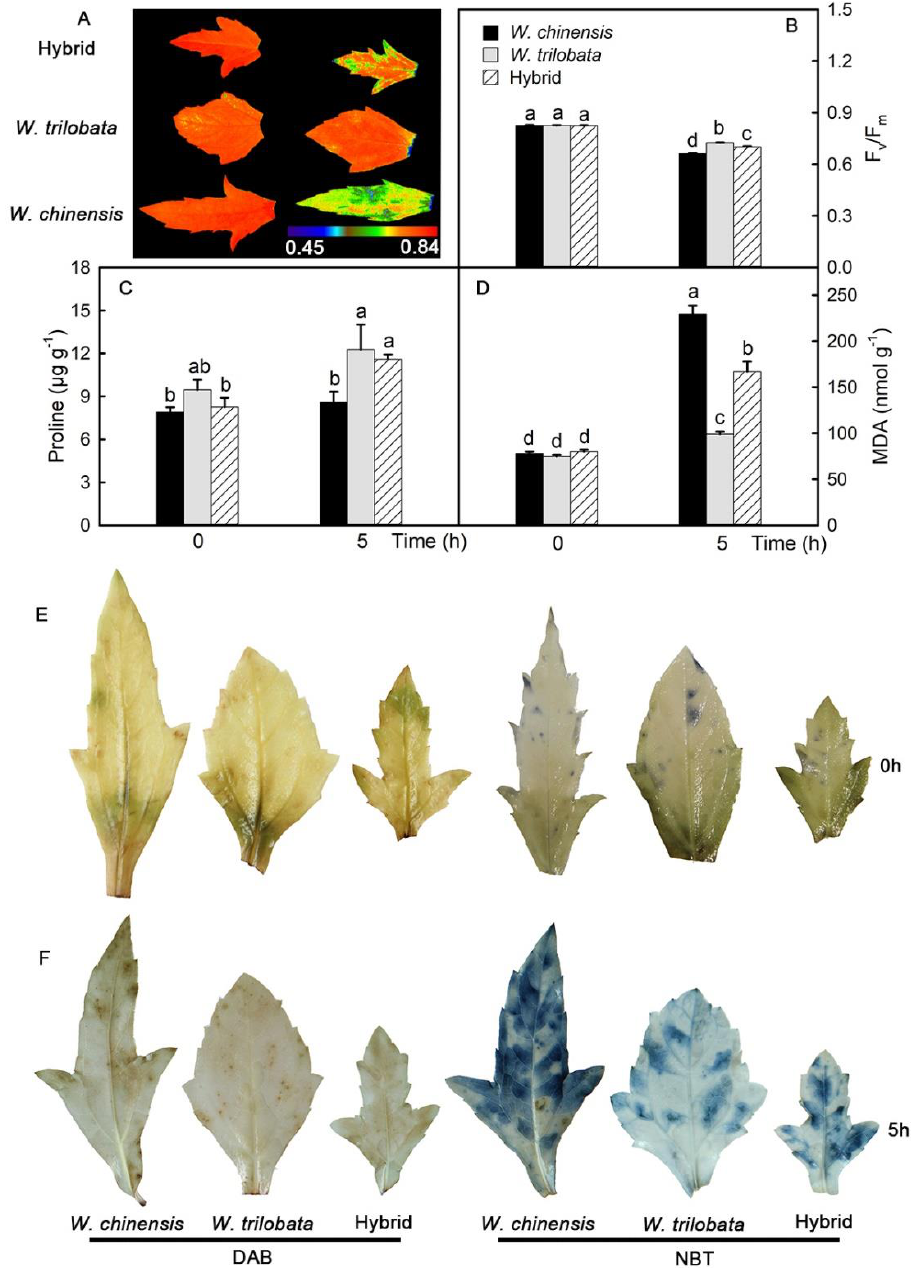
Figure 3. Maximum photochemical efficiency (Fv/Fm) and reactive oxygen species. Fv/Fm of detached leaves at 0 and 5 h ( A , B ). Proline content in detached leaves ( C ). Malondialdehyde (MDA) content of detached leaves at 0 and 5 h ( D ). Accumulation of hydrogen peroxide (DAB) and superoxide cation (NBT) in detached leaves at 0 and 5 h ( E , F ). The data are shown as means ± standard errors (SE), and the study included five biological replicates. Different letters (a, b, c, d) on the bar represent significant differences at p < 0.05 (Duncan’s test).